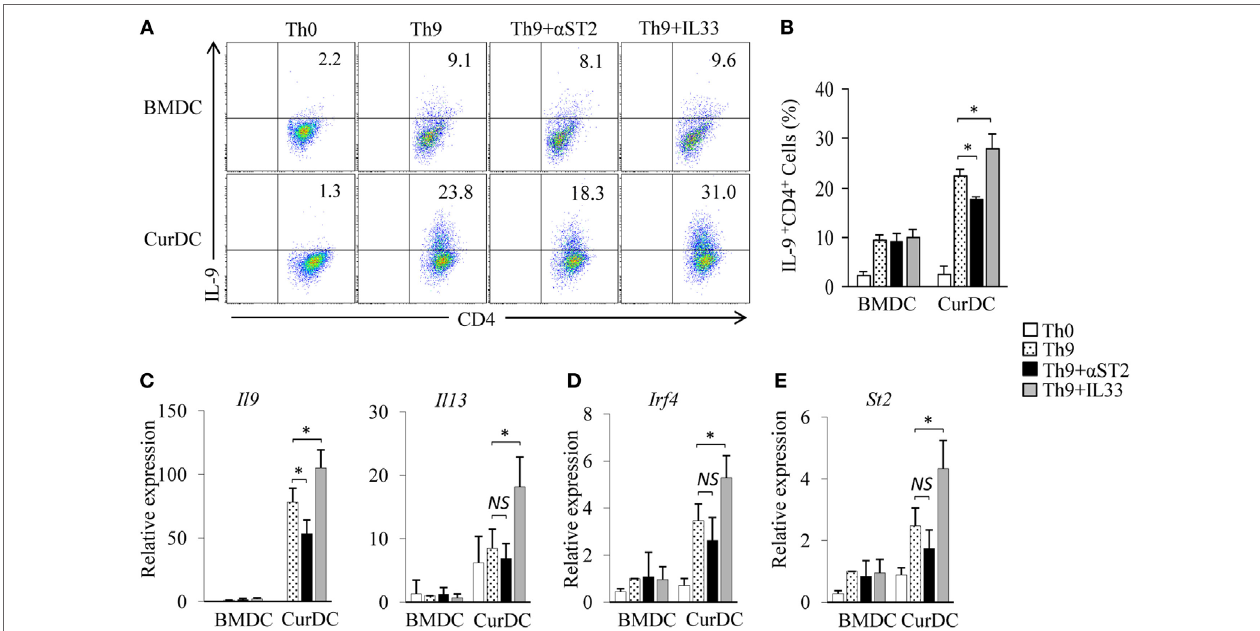
FigUre 2 | Interleukin (IL)-33 contributes to dectin-1-activated dendritic cell (DC)-induced Th9 priming. Naïve CD4 + T cells were cocultured with BMDCs or CurDCs under Th9-polarizing conditions with or without addition of an anti-ST2 blocking antibody ( α ST2) or IL-33. Cell cultures without (Th0) addition of Th9-polarizing cytokines transforming growth factor β and IL-4 were used as controls. Cells were cultured for 3 days. (a) Flow cytometry analysis of IL-9-expressing CD4 + T cells. Numbers in the dot plots represent the percentages of IL-9 + CD4 + T cells. (B) Summarized results of three independent experiments obtained in (a) . The experiments were performed three times ( n = 3). Quantitative polymerase chain reaction analysis of Il9 and Il13 (c) , Irf4 (D) , and St2 (e) in T cells. Expression was normalized to Gapdh and set at 1 in BMDC-induced Th9 cells. The experiments were performed three times ( n = 3). Data are representative of three (a) independent experiments or presented as mean ± SD of three (B–e) independent experiments. NS , non-significant; * P < 0.05